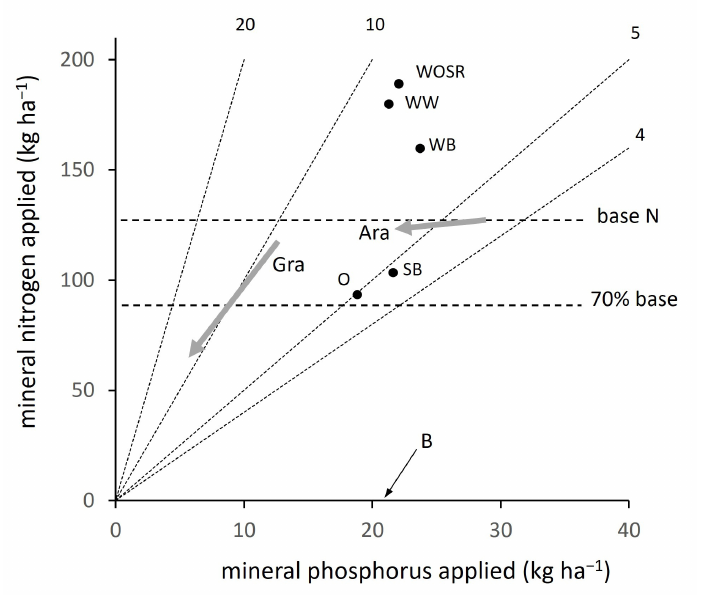
Figure 1. Trends, shown by grey arrows, in mineral nitrogen and phosphorus inputs for grassland (Gra) and arable (Ara) for the fertiliser census area of Scotland [39]. In each of the two trends, the beginning of the arrow is located at the mean for the five years around 1990 and the point of the arrow at the mean for the five years around 2014 (the period of the first phase of the CSC platform presented here). Numbers show the N:P ratio for guidance. Symbols show the positions for the main grain crops: winter oilseed rape (WOSR), winter wheat (WW), winter barley (WB), spring barley (SB), oats (O), and beans (B, to which no nitrogen is usually given). Horizontal lines show the mean nitrogen input to arable in 1990 (the base for emissions estimates) and 70% of the base (see text for